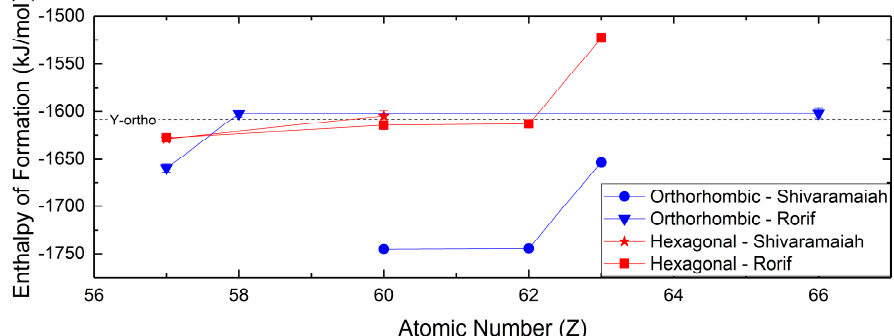
Figure 8. Enthalpies of formation for hexagonal and orthorhombic hydroxycarbonates from Rorif [127] and Shivaramaiah [99]. Value for orthorhombic yttrium hydroxycarbonate is from Shivaramaiah